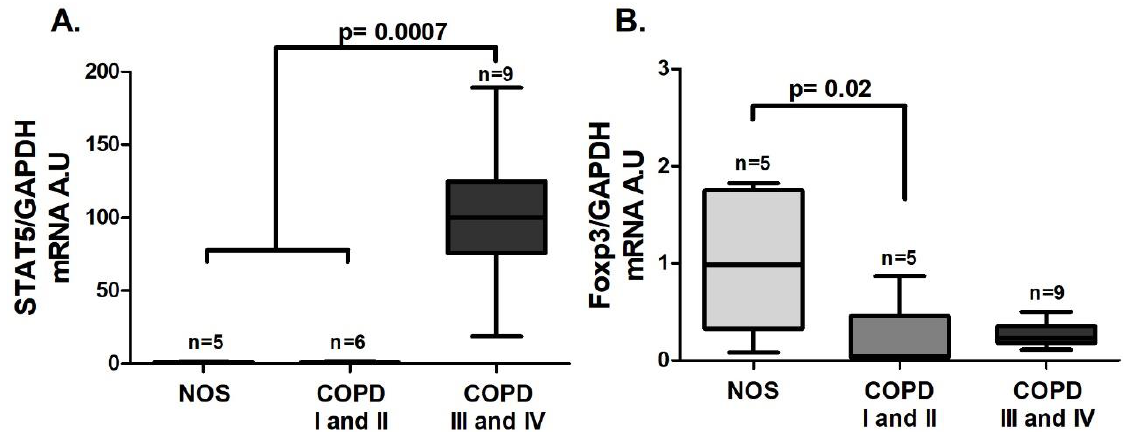
Figure 7. Treg transcription factors in the systemic response. Treg transcription factors gene expression in white blood cells: ( A ) increased STAT5 gene expression ( p = 0.0007, Kruskal–Wallis test) in the COPD III and IV group compared to the other groups; ( B ) decreased Foxp3 gene expression ( p = 0.02, Kruskal–Wallis test) in the COPD I and II group compared to the NOS group. The data are expressed as the median and interquartile range. A.U: Arbitrary Units.